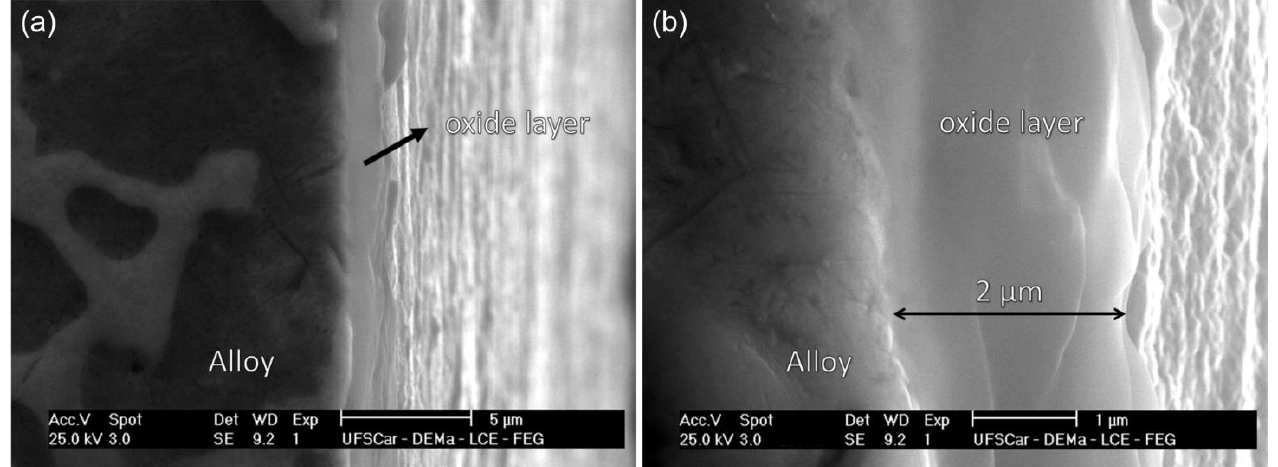
Figure 13. SEM micrographs of the nickel-based alloy after the oxidation analysis at 900 ◦ C with emphasis on the oxide layer formed: ( a ) lower and ( b ) higher magnification.